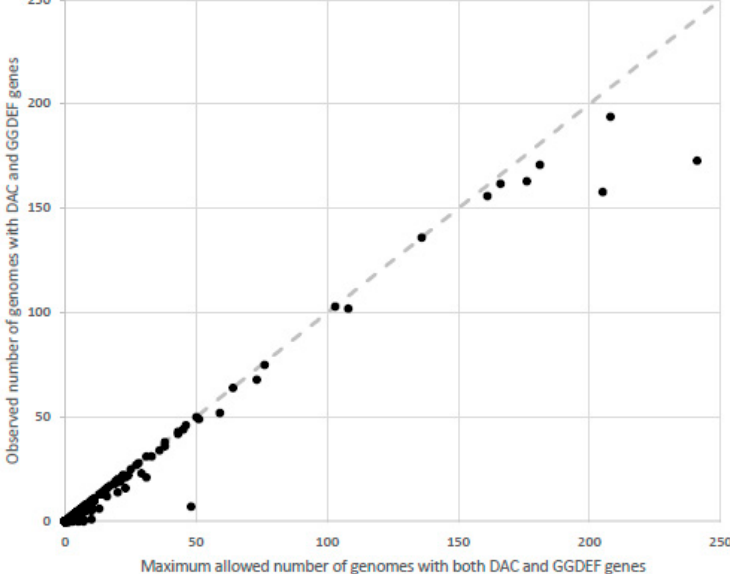
Figure 9. Lack of anti-correlation in the distribution of DAC and GGDEF genes per prokaryotic clades. Each dot represents a prokaryotic class, such as Gammaproteobacteria or Bacilli, as defined in the NCBI’s Taxonomy Database. For each class, the number of genomes harboring at least one DAC and one GGDEF gene and the number of genomes harboring both was calculated. If, for a given class, we consider the number of genomes with DACs and the number of genomes with GGDEF, the smallest of these numbers is the maximum number of genomes that could, in principle, carry both genes. That number is seen on the horizontal axis while the actual number of genomes carrying both genes is on the y -axis. These numbers are very close to the diagonal line, indicating that, in most cases, if members of a given lineage are carrying both DAC and GGDEF, they tend to keep both genes, instead of having to choose between them.